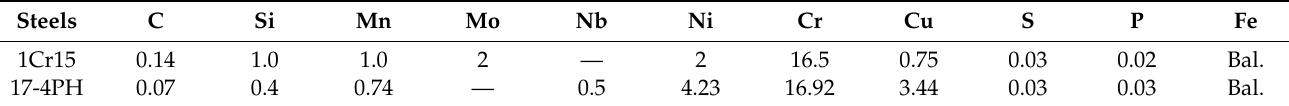
Table 1. Chemical composition (wt.%).